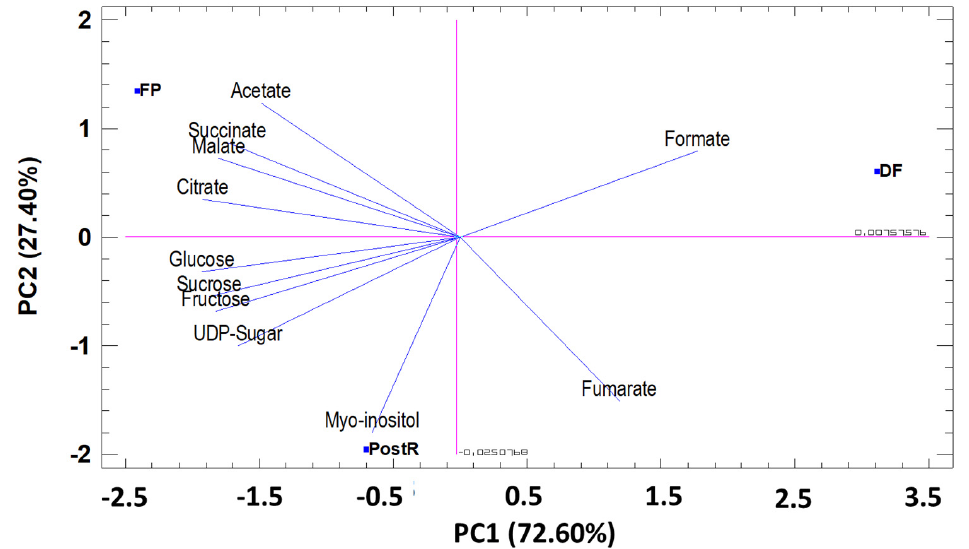
Figure 5. Principal components analysis (PC1 and PC2) for sugar and organic acids identified in pomegranate leaves cultivated in three different phenological stages. PC1 (72.60%) and PC2 (27.40%).